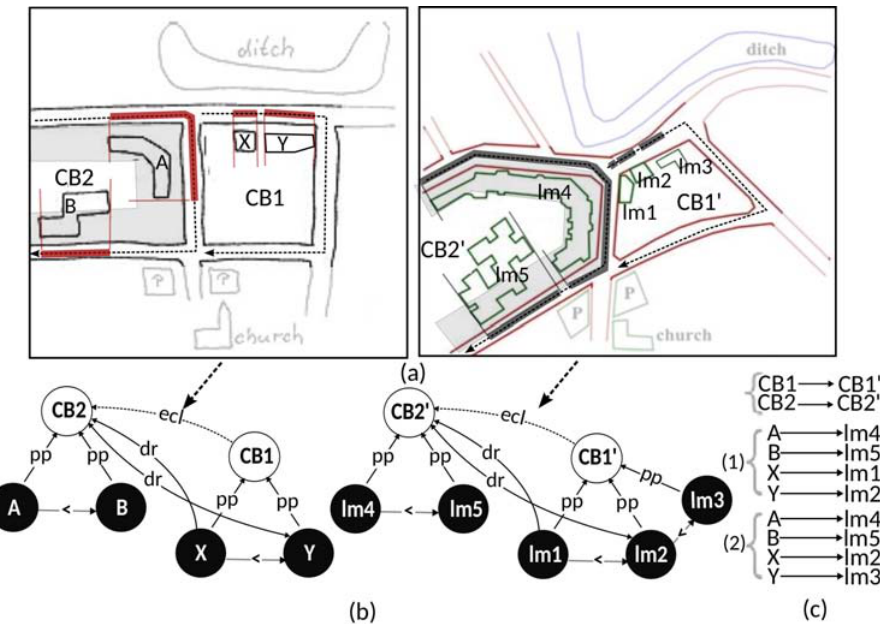
Figure 11: (a) Landmarks and city-blocks in the sketch and geo-referenced maps, (b) rela- tions between city-blocks and landmarks using the RCC 11 , RCC 5 , and the coarse IA re- lations, (c) diagram representing possible alignments (1 and 2) of landmarks in city-blocks (CB1, CB2) with the landmarks in city-blocks (CB1’, CB2’) in geo-referenced